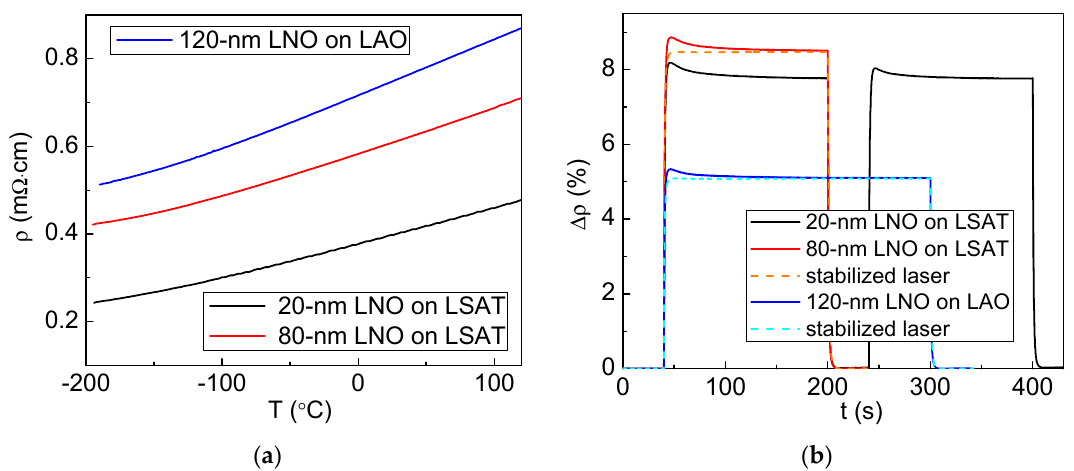
Figure A3. ( a ) Resistivity temperature dependence for other tested LNO films: two films deposited on LSAT with thicknesses 20 and 80 nm as well as a 120-nm thick film on LAO. ( b ) Percentage change of their room-temperature resistivity at long-term illuminations by the blue laser at optical power 0.8 W.